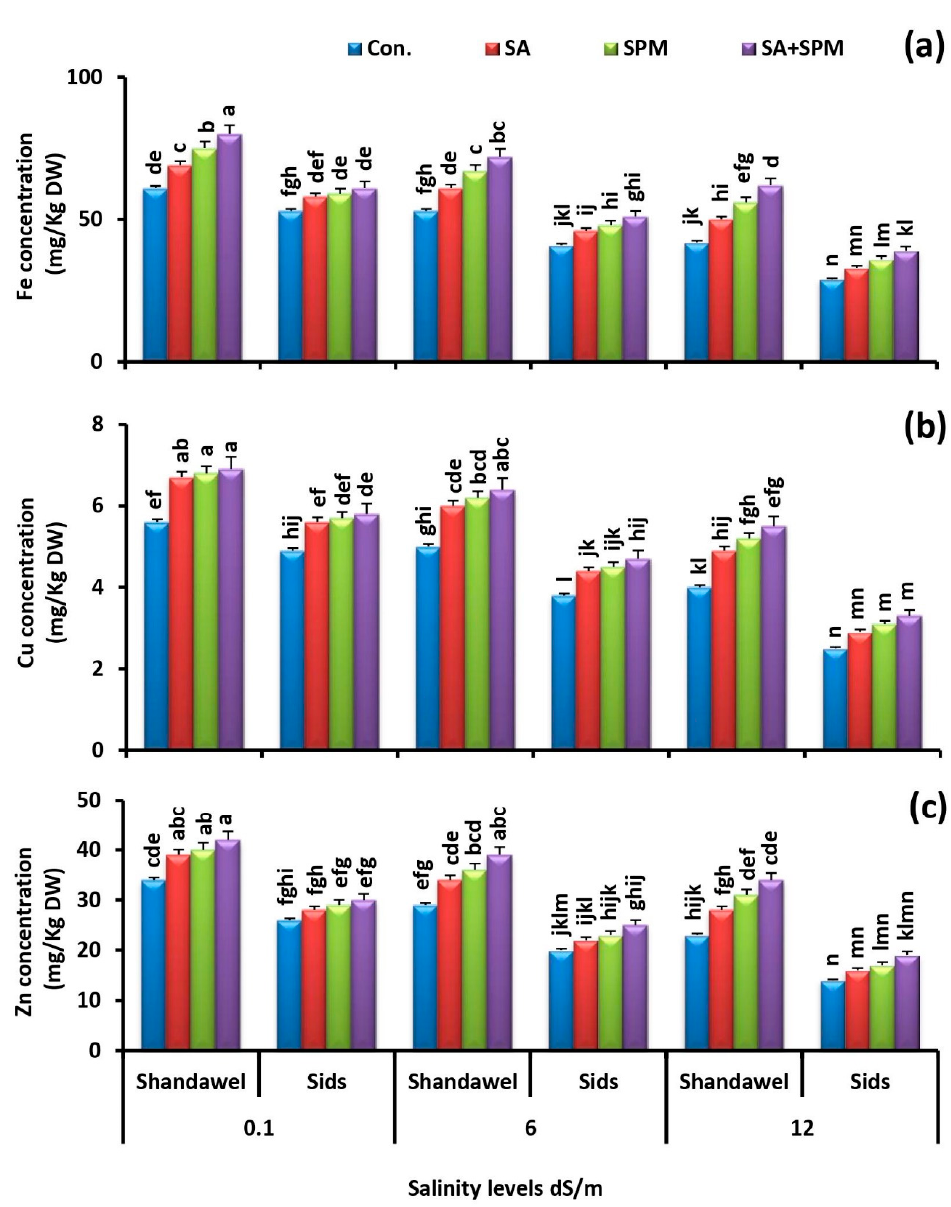
Figure 7. Influence of salicylic acid (SA; 100 mgL − 1 ) and/or spermine (SPM; 30 mgL − 1 ) on the concentration of ( a ) iron, ( b ) copper, and ( c ) zinc in grains of two wheat cultivars (Shandawel 1 and Sids 14) grown under 0.1, 6, and 12 dS m − 1 salinity levels. Data are mean of four replicates (n = 4). Different letters indicate significant differences at ( p < 0.05) level, according to Duncan’s test.